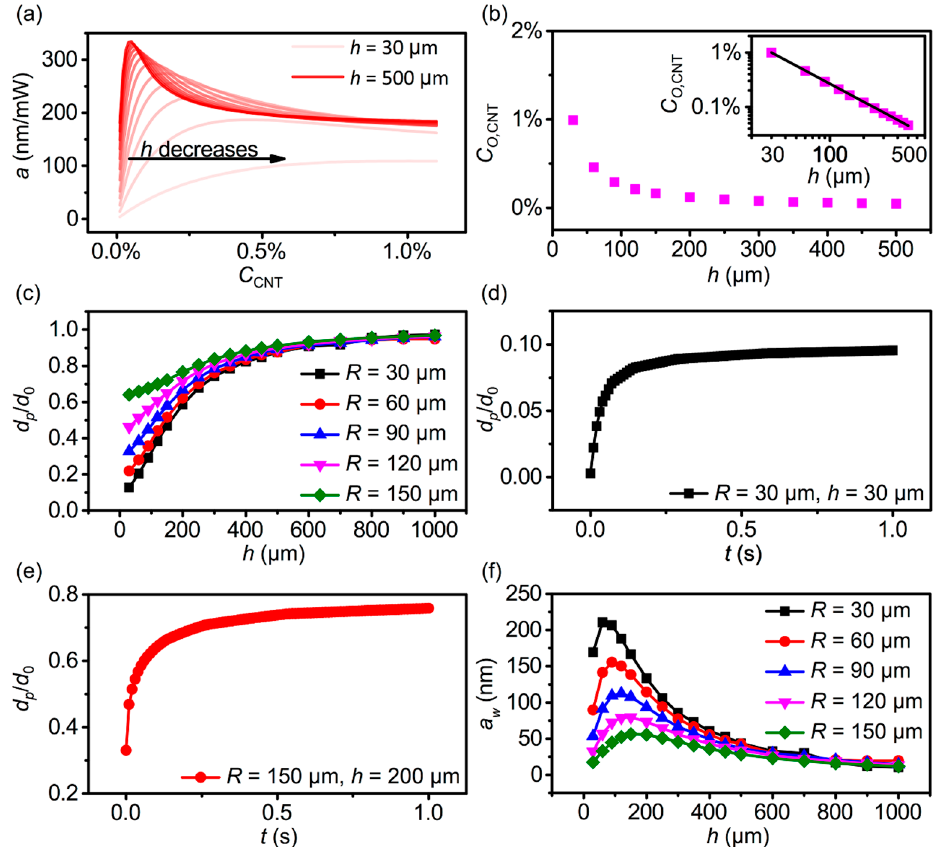
Figure 3. Optimization of PDMS–CNT films on the basis of FEA. ( a ) Actuation efficiency a vs. C CNT for various h with R = 60 µ m. ( b ) Optimal CNT concentration C O,CNT vs. h and (inset) the power law relationship between these quantities. ( c ) Crosstalk magnitude d p / d 0 where p = 150 µ m plotted vs. h with various values of R . Time dependency of d p / d 0 for systems with ( d ) R = 30 µ m and h = 30 µ m compared with ( e ) R = 150 µ m and h = 200 µ m. ( f ) Calculated working efficiency a w = (cid:3435)𝑑 (cid:2868) (cid:3398) 𝑑 (cid:3043) (cid:3439)/𝑃 vs. h .